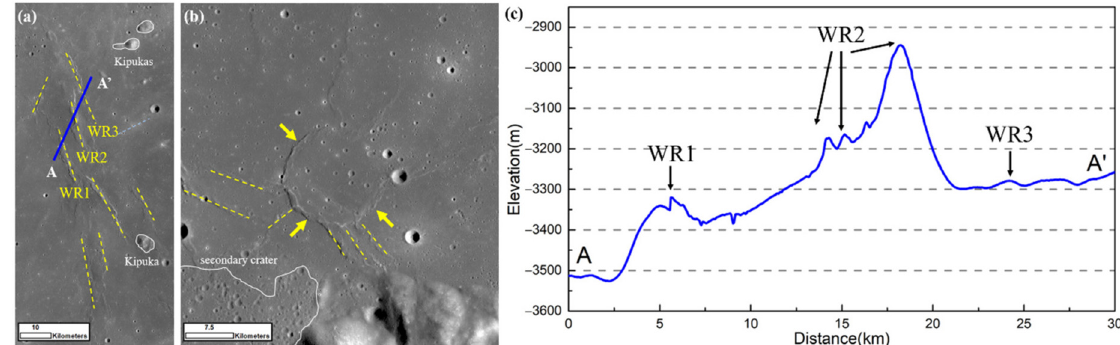
Figure 5. Wrinkle ridges in the Crisium basin. ( a ) Linear ridges and ( b ) arc-shaped ridges. The yellow dashed lines denoted the orientations of wrinkle ridges and sky-blue dashed line shows the restricted ejecta orientation. AA’ shows the location of the profile in Figure 5c. ( c ) The topographic profile of the blue line